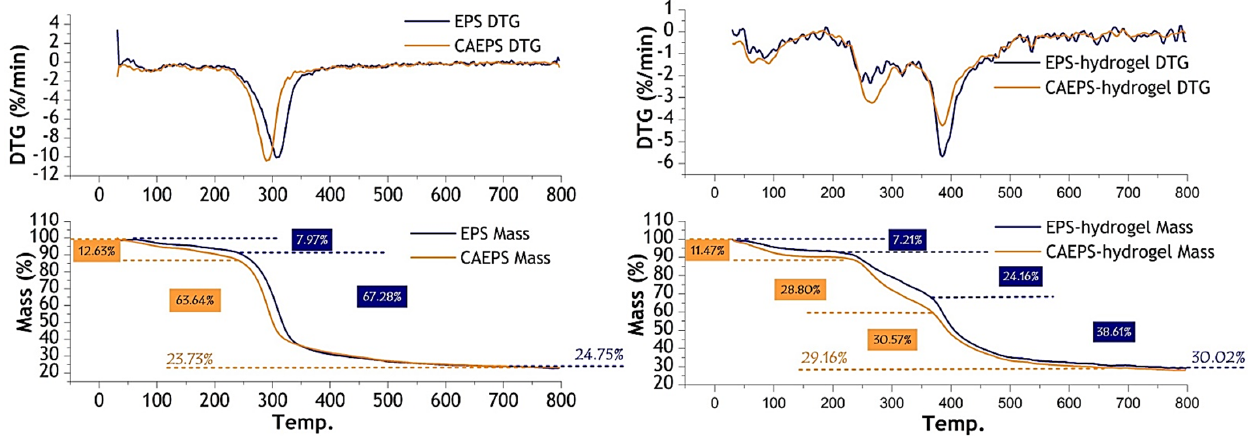
Figure 4. Thermogravimetric analysis curve of EPS, CAEPS, EPS-, and CAEPS-hydrogel. Note: 3 mg EPS and CAEPS was measured for room temperature to 800 ◦ C in the atmosphere of nitrogen,